Question: From the figure, is the trend upward or downward?
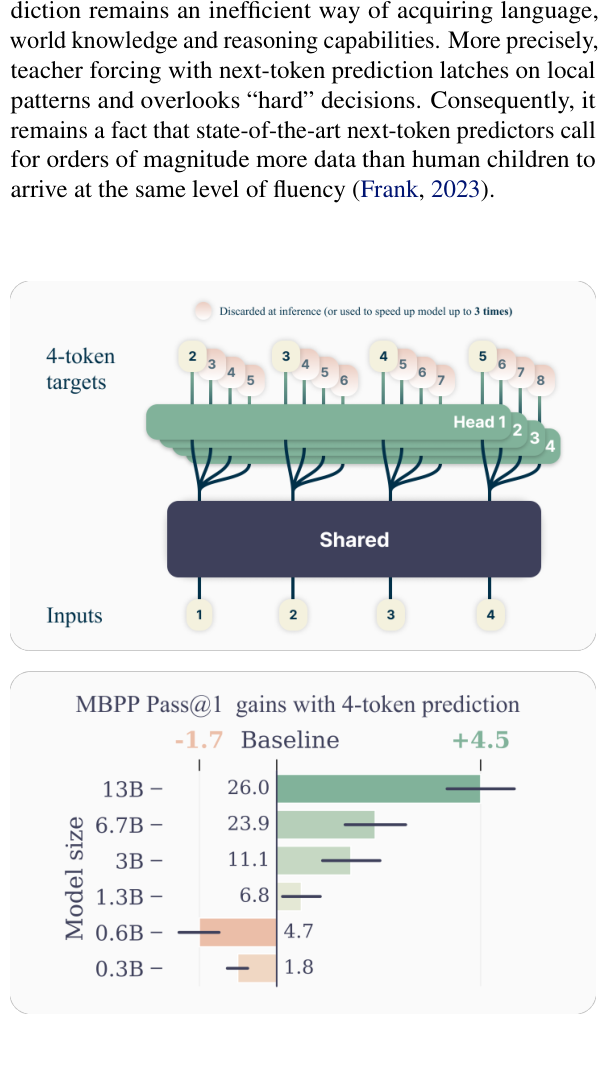
Answer: increasing